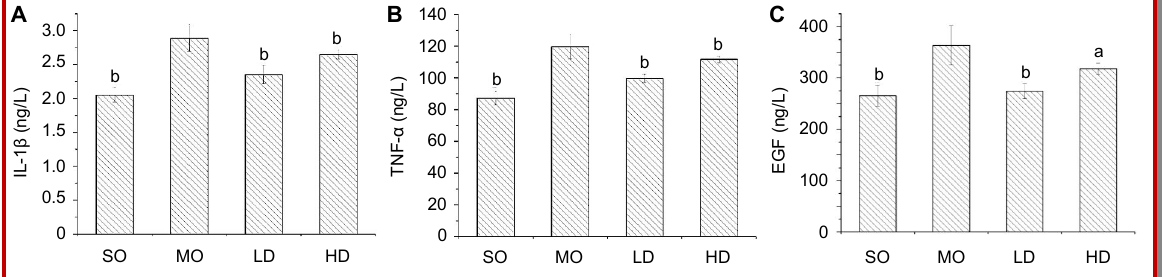
Figure 2: Effect of T. patula water extract on the contents of IL-1 (cid:451), TNF- (cid:450) and EGF in prostate tissue. Values are in mean ± SD; n = 10; a = p<0.05, b = p<0.01 Vs the model group (MO)